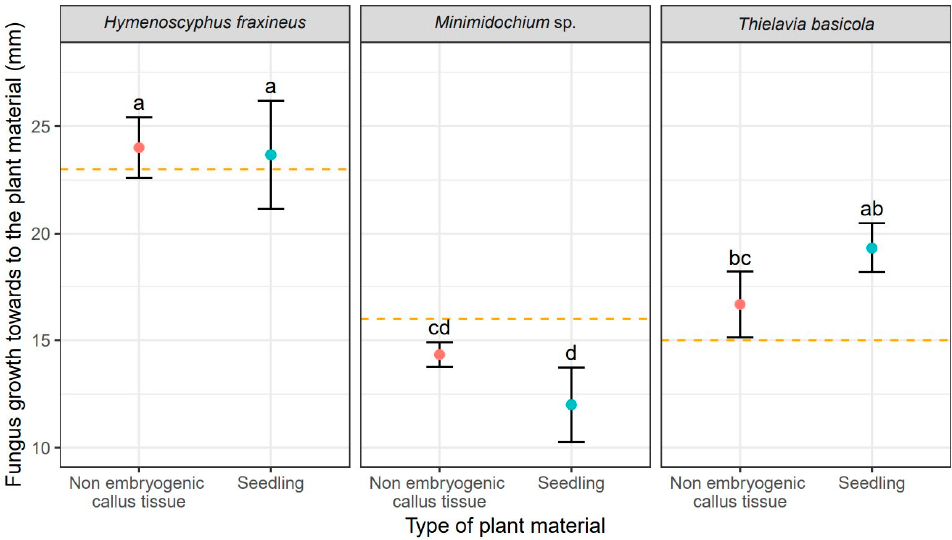
Figure 1. Mean values (points) and standard deviations (error bars) for fungus size in the direction towards to the plant material (red—non embryogenic callus tissue, light blue—seedling). The orange dashed lines show fungus size in the experiments without plant material. The same letters indicate the lack of statistically significant differences ( p < 0.05).